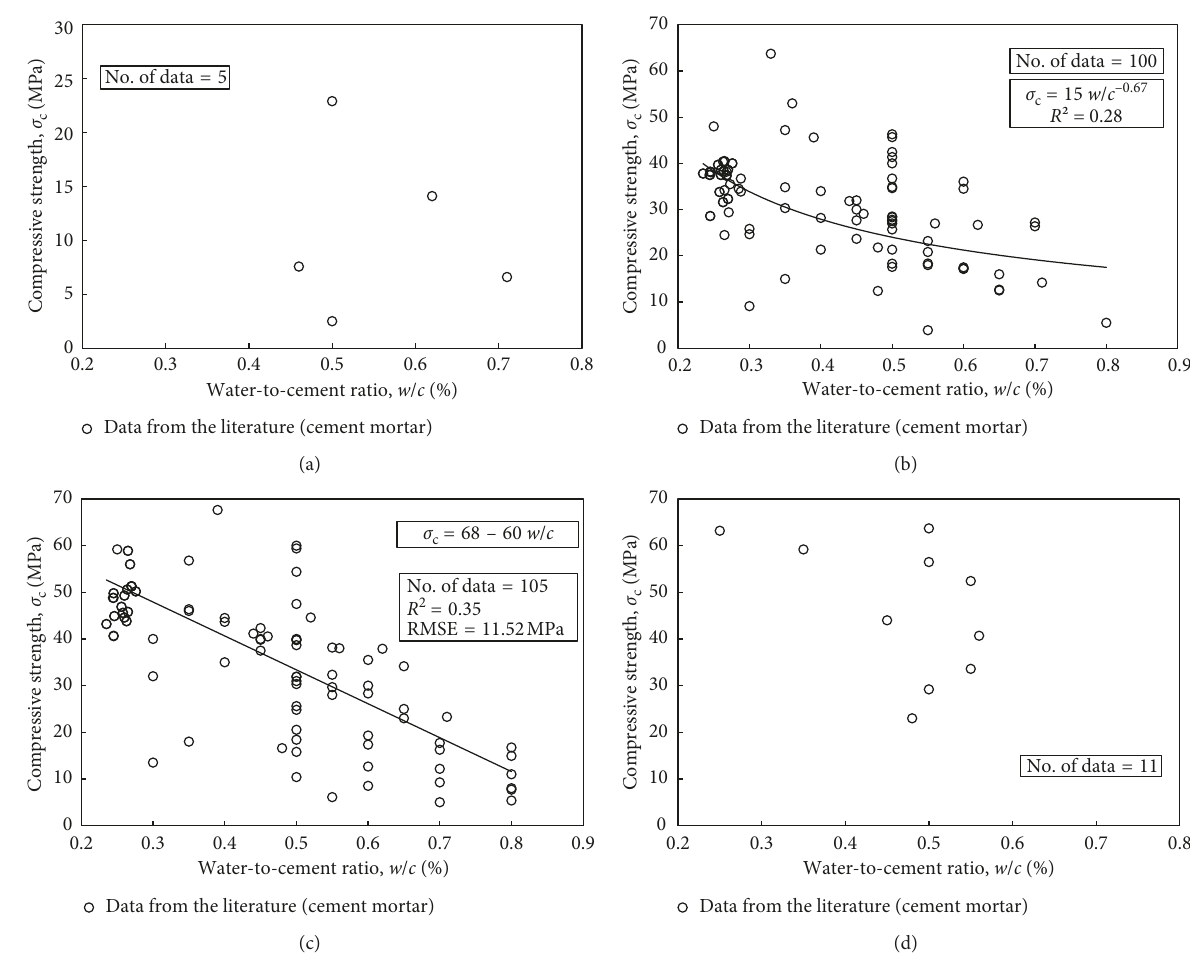
Figure 6: Variation between w/c and compressive strength of cement mortar at different curing times: (a) 1day; (b) 7days; (c) 28days; (d) 90days.